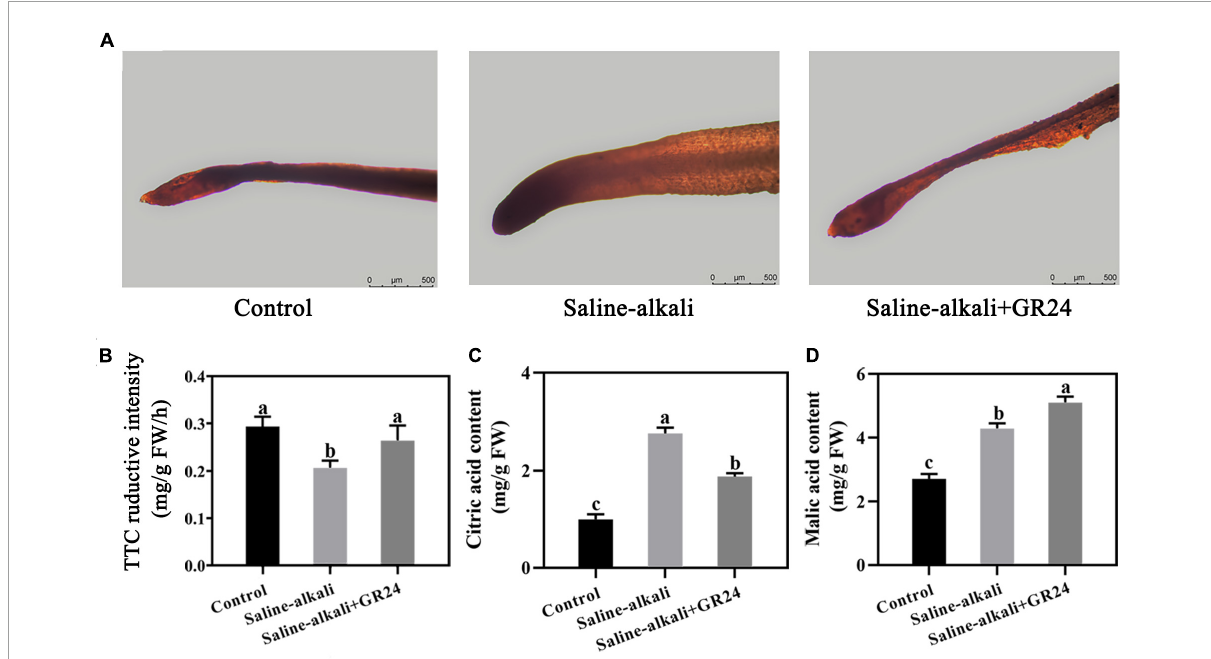
FIGURE7 Effects of GR24 treatment on root activity (A) , triphenyltetrazolium chloride (TTC) reductive intensity of apple roots (B) , citric acid content of apple leaves (C) , and malic acid content of apple leaves (D) under salinity-alkalinity stress. The data represent the mean ± SD of three biological replicates. Different lowercase letters indicate significant differences according to Fisher’s least significant difference ( P <